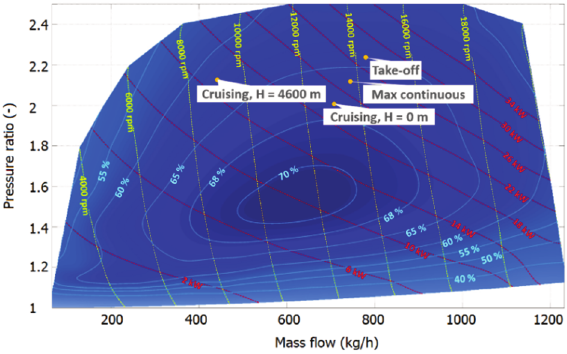
Fig. 8. Eaton TVS R900 compressor map with calculated operating points [12] The determined operating points for the Eaton TVS R410 compressor are shown in Fig. 9. The efficiency achieved varied in the range of 65-66%. The highest effi- ciency equal to 66% was obtained for the cruising power point at H = 4600 m. For the cruising power at H = 0 m, the efficiency was equal to 65%. As the height increases, the operating points move on the map upwards through the area with the highest efficiency of the